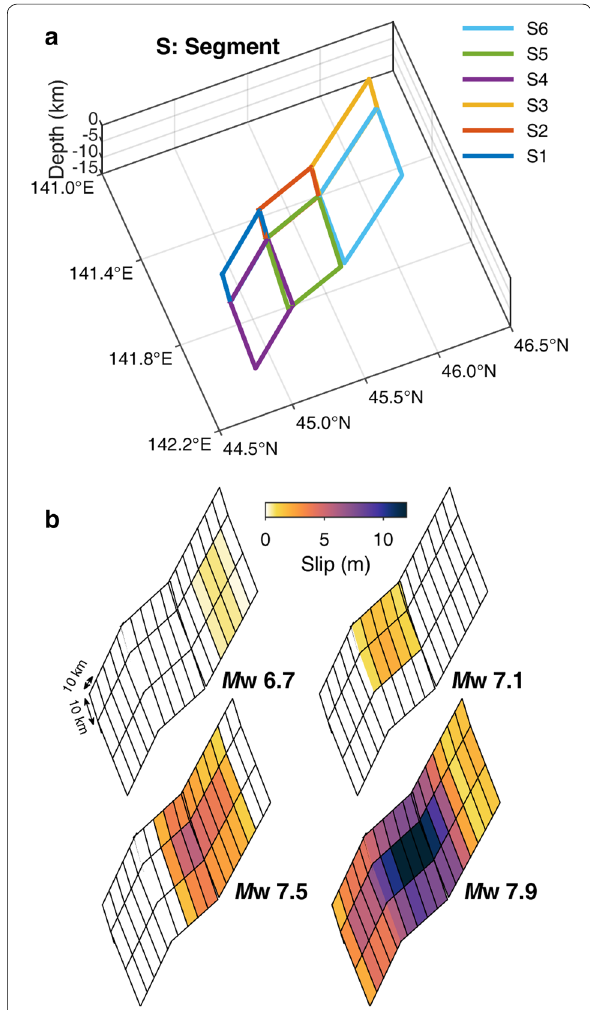
Fig. 2 a Segmentation of the F01 fault. b Samples of stochastically generated slip distribution for different magnitudes on the F01